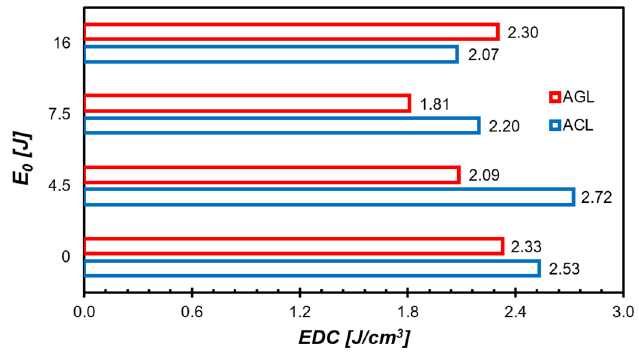
Figure 8. Comparison of EDC values for studied FML plates. The ACL laminates tend to dissipate more energy per volume unit than AGL laminates.